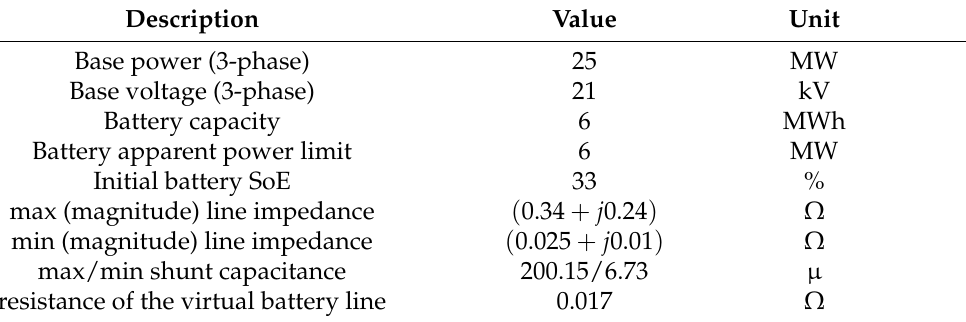
Figure 4. Diagram of the 34-bus grid. The blue arrows indicate connected loads. Table 1. Grid parameters for the 34-bus